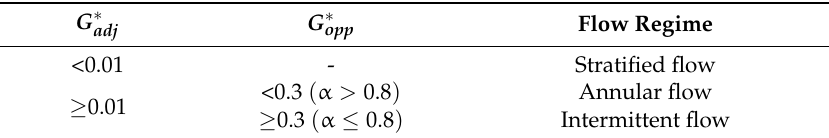
Table 3. Criteria for flow pattern